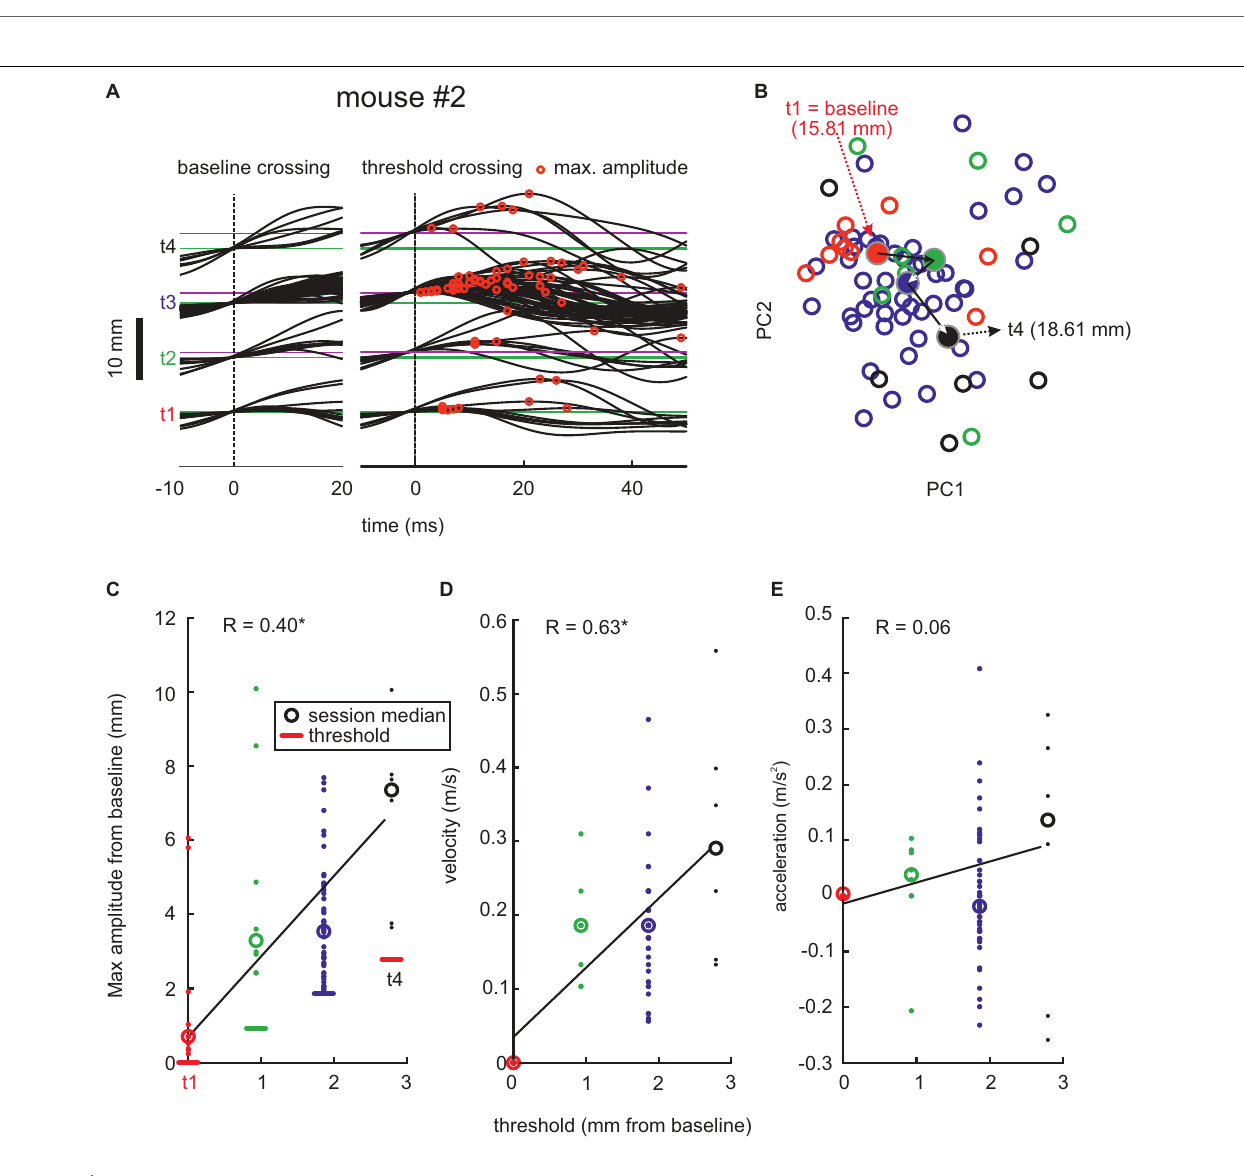
FIGURE 5 | Adaptive whisking later than 12 days after contralateral RW lesion. Example session. (A–E) Same conventions as in Figures 2 , 4